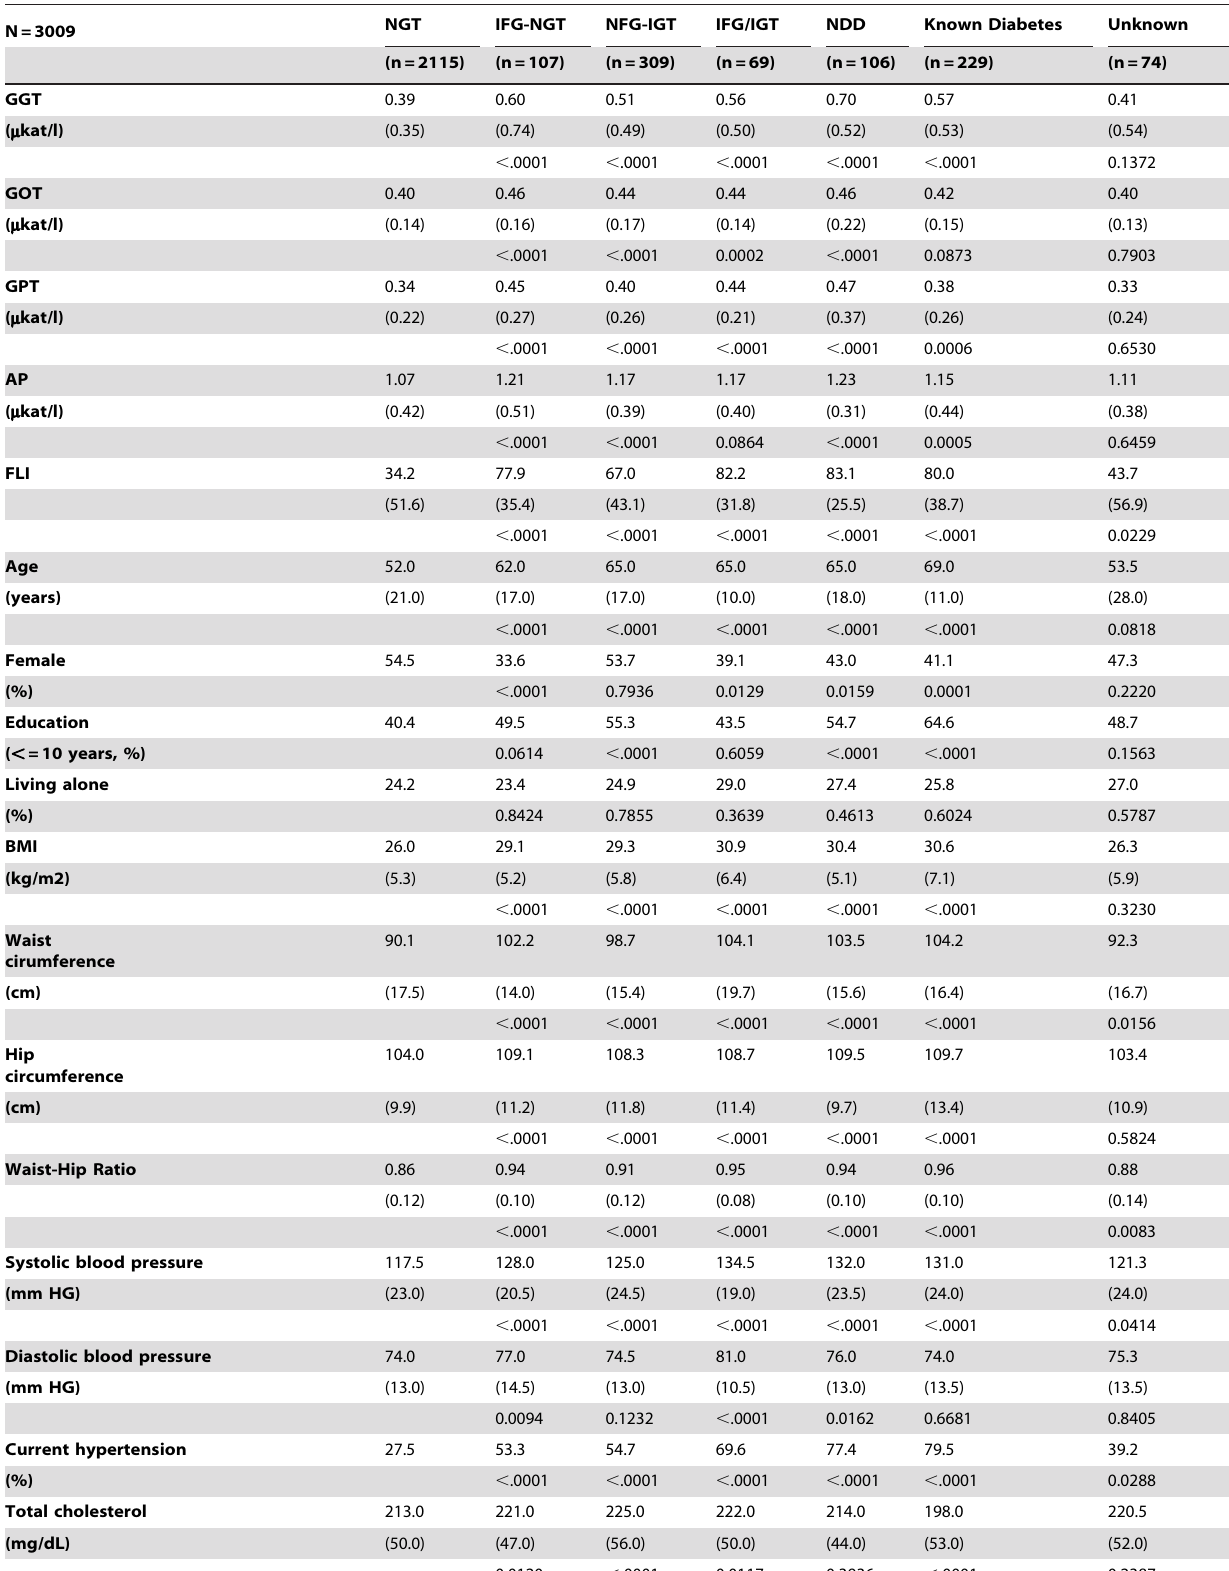
Table 1. Study characteristics by NGT, IFG-NGT, NFG-IGT, IFG/IGT, NDD, known Diabetes and unknown glucose tolerance